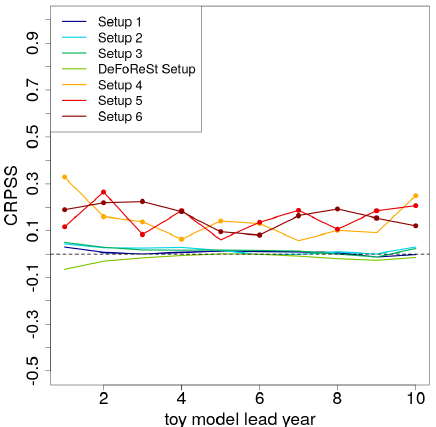
Figure 7. CRPSS of different toy model setups with high potential predictability ( η = 0 . 8, colored lines) post-processed with boosted recalibration. The associated toy model setups post-processed with DeFoReSt are used as reference for the skill score. CRPSS larger zero implies boosted recalibration performing better than DeFoR- eSt. Colored dots in Fig. 7 denote significance in the sense that the 0.025 and 0.975 quantiles from the 100 experiments do not in- clude